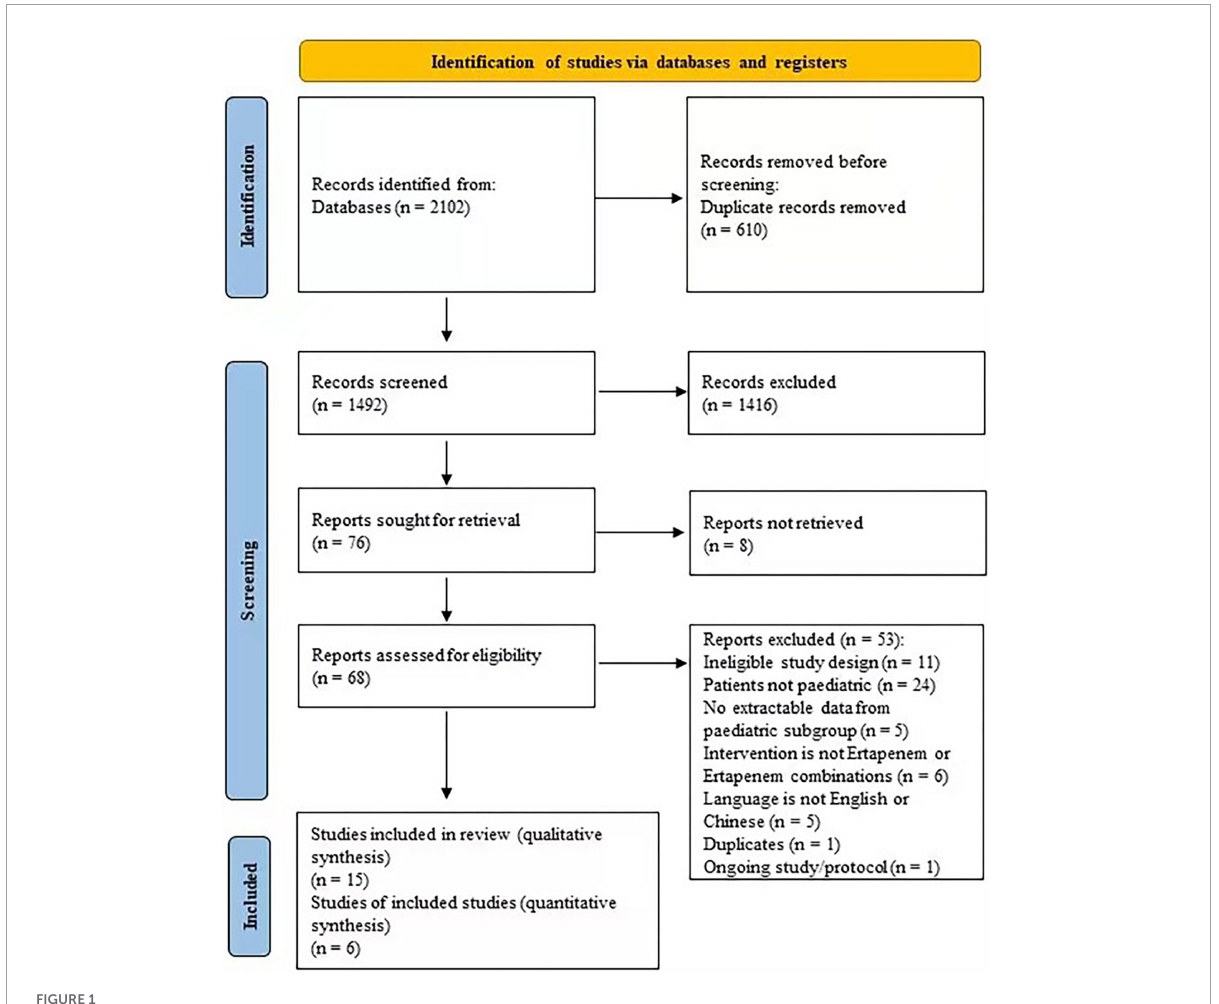
FIGURE1 Study flow